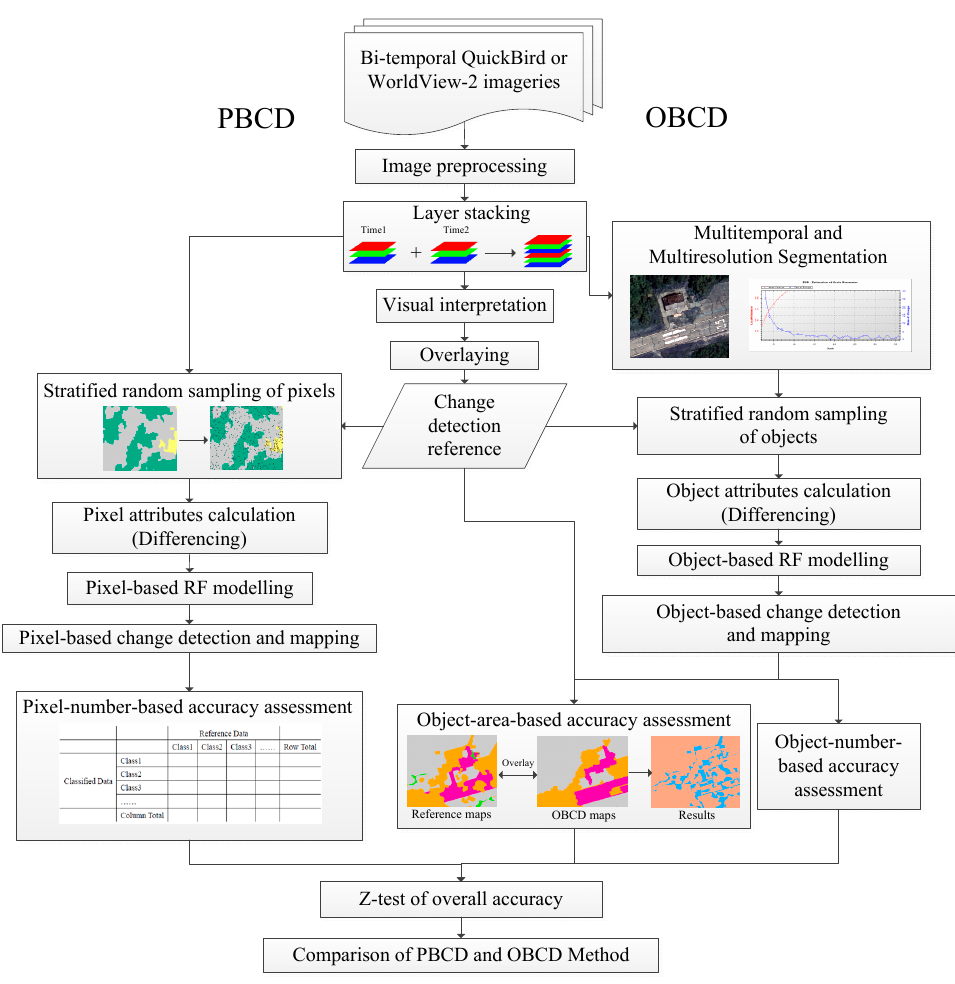
Figure 2. Schematic of the procedures implemented in coral reef change detection using the pixel-based change detection (PBCD) and object-based change detection (OBCD) methods and the comparison of their results.